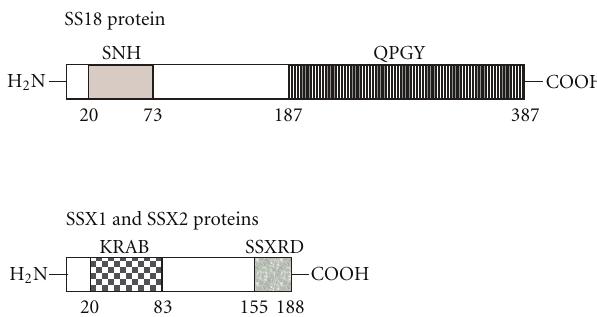
Figure 1: Schematic diagram shows the domains structure of SS18 and SSX proteins. The amino acid residues representing the boundaries of selected domains are indicated. SNH-SS18 N- terminal domain; QPGY-SS18 domain rich in glutamine, proline, glycine, and tyrosine; KRAB-SSX Kr¨uppel-associated box domain; SSXRD-SSX transcriptional repression